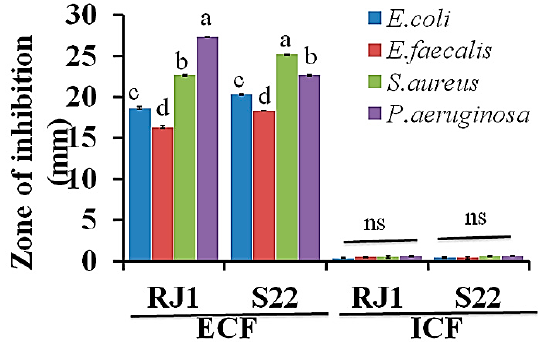
Figure 2. Antimicrobial activity of intra- and extracellular fluid of selected LAB strains against pathogenic bacteria according to the agar-well diffusion method. (ECF, extra cellular fluid; ICF, intracellular fluid from L. plantarum RJ1 and P. pentosaceus S22). The results are expressed as the mean